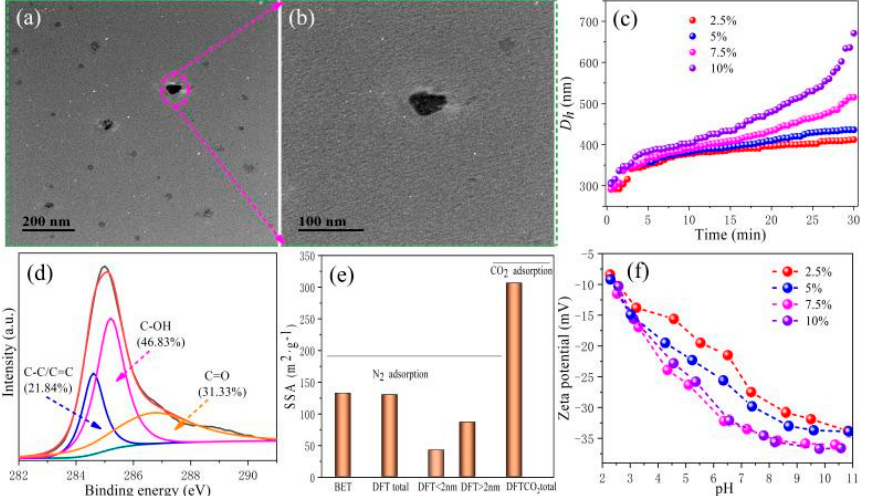
Figure 1. Characterization of nano-BC. ( a , b ) TEM images, ( c ) Aggregation profiles of nano-BC in DI water, ( d ) High-resolution XPS C 1s spectra, ( e ) Specific surface area (SSA) according to N 2 and CO 2 gas adsorption, and ( f ) ζ potential as a function of pH.